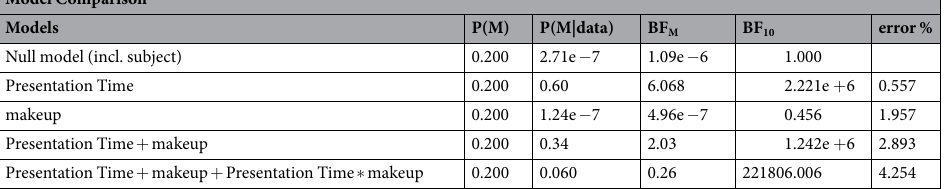
Table 2. Model comparison outputs for the results of Experiment 2. Note . All models include